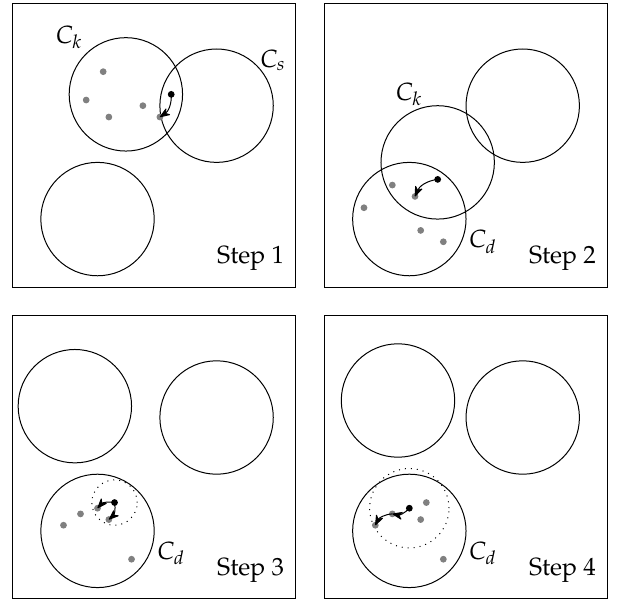
Figure 5. Scheduling